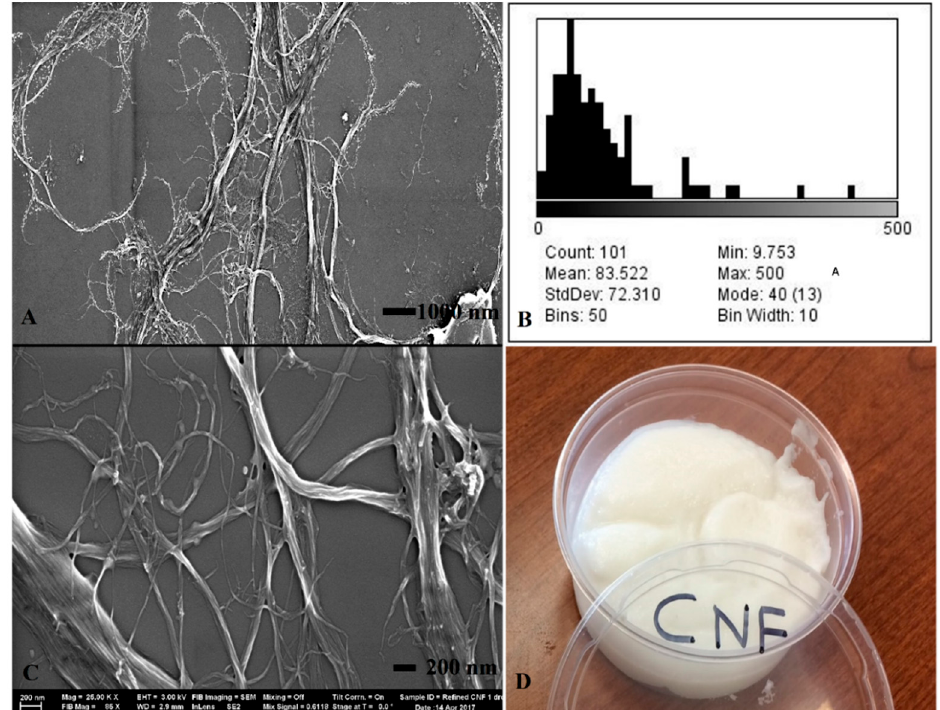
Figure 1. SEM of pure cellulose nanofibrils (CNF) used in the formulation of hybrid membranes: At 5K magnification ( A ) and 25K magnification ( C ). Fibril width distribution histogram is presented in ( B ), physical appearance of a 3% by weight solids CNF suspension is seen in ( D ).